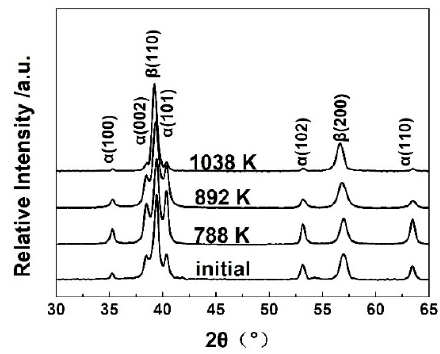
Figure 5. XRD patterns of the Ti-55531 alloys quenched from different temperatures.